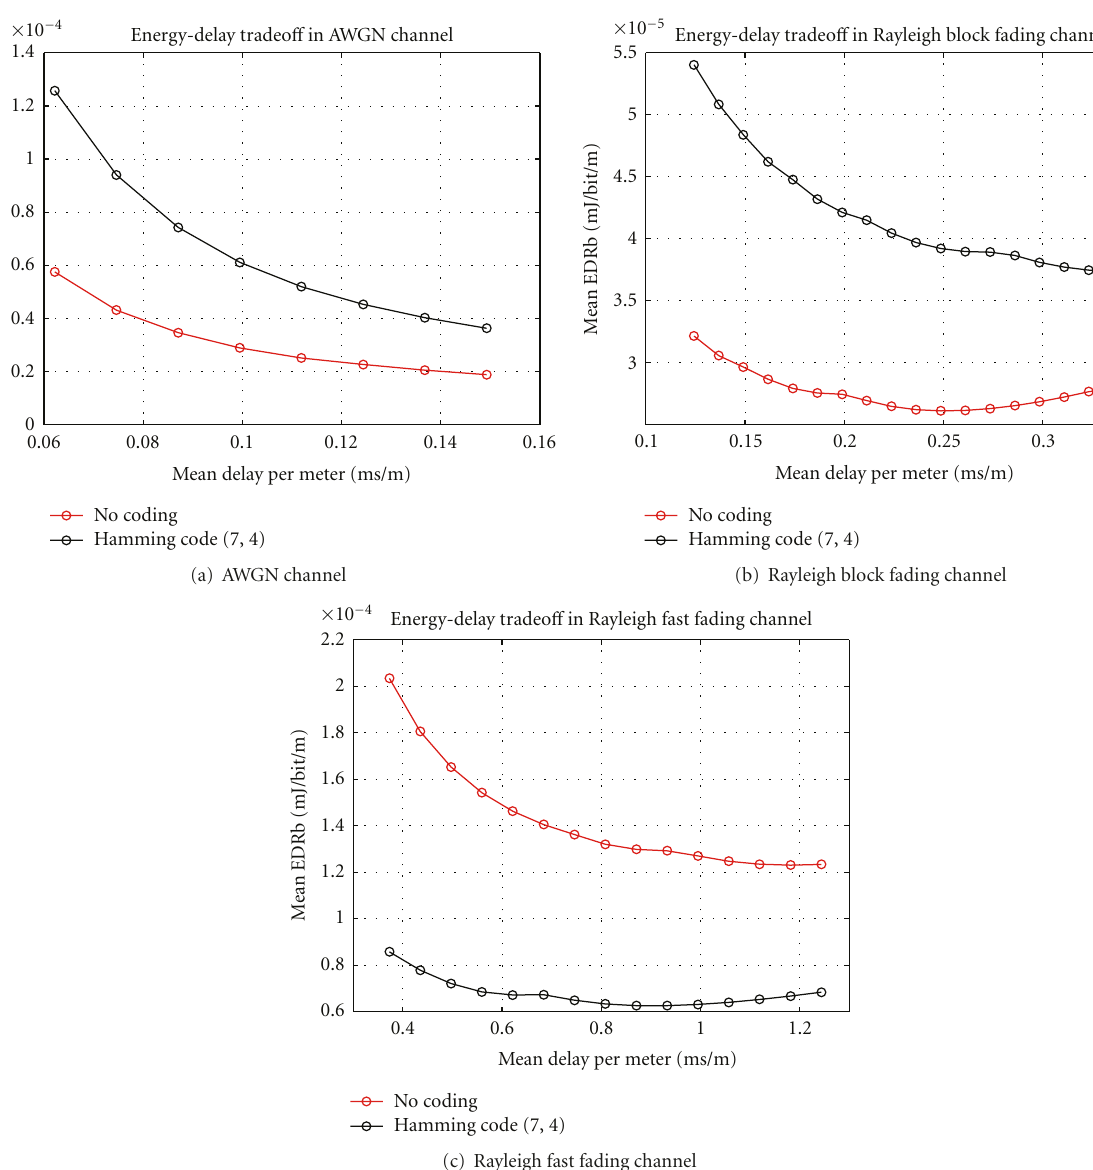
Figure 6: E ff ect of coding on energy-delay tradeo ff in di ff erent